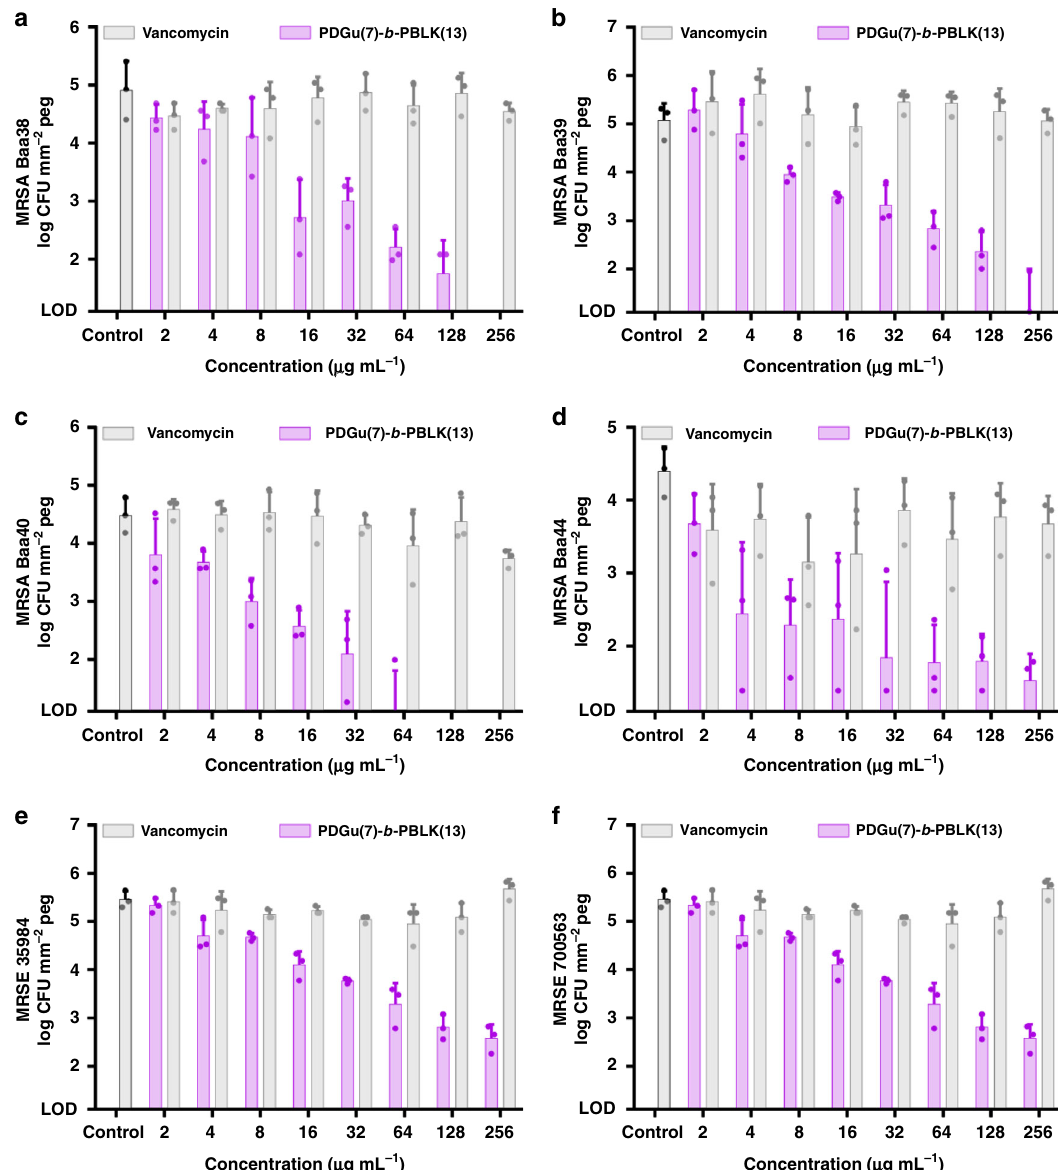
Fig. 5 PDGu(7)- b -PBLK(13) eradicates bio fi lms of HA-MRSA and MRSE strains. It shows dose-dependent eradication of bio fi lm bacteria under conditions that promote polysaccharide intercellular adhesion; y -axis: bio fi lm bacteria (CFU mm − 2 peg) formed by different HA-MRSA strains ( a ATCC BAA38, b ATCC BAA39, c ATCC BAA40, d ATCC BAA44) and MRSE strains ( e ATCC 35984, f ATCC 700563). (Vancomycin is used as antibiotic control.) Data are presented as mean ± standard The block co-beta-peptide ( PDGu(7)- b -PBLK(13) ) demon- as a bacteria-triggered surfactant leading to bio fi lm dispersal. As resistance toward all classes of antibiotics rapidly evolves and spreads 77 , the outstanding ef fi cacy of PDGu(7)- b -PBLK(13) against S. aureus persisters and bio fi lms, as well as its excellent safety window, makes this block co-beta-peptide a valuable can- didate to treat MRSA infections.